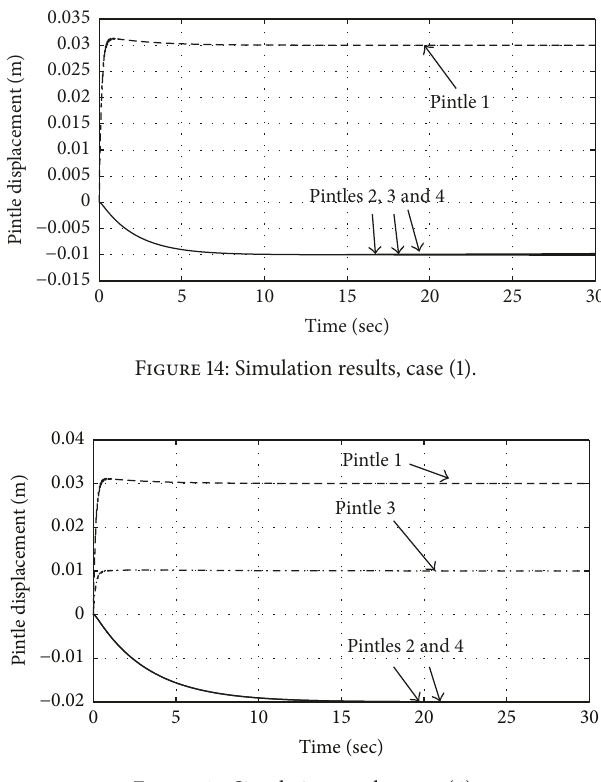
Figure 16. Since the +𝑦 and −𝑦 pintles are moved equally, the thrust in the 𝑦 -axis is eliminated and no net thrust will be generated. The same analysis can be performed for the 𝑧